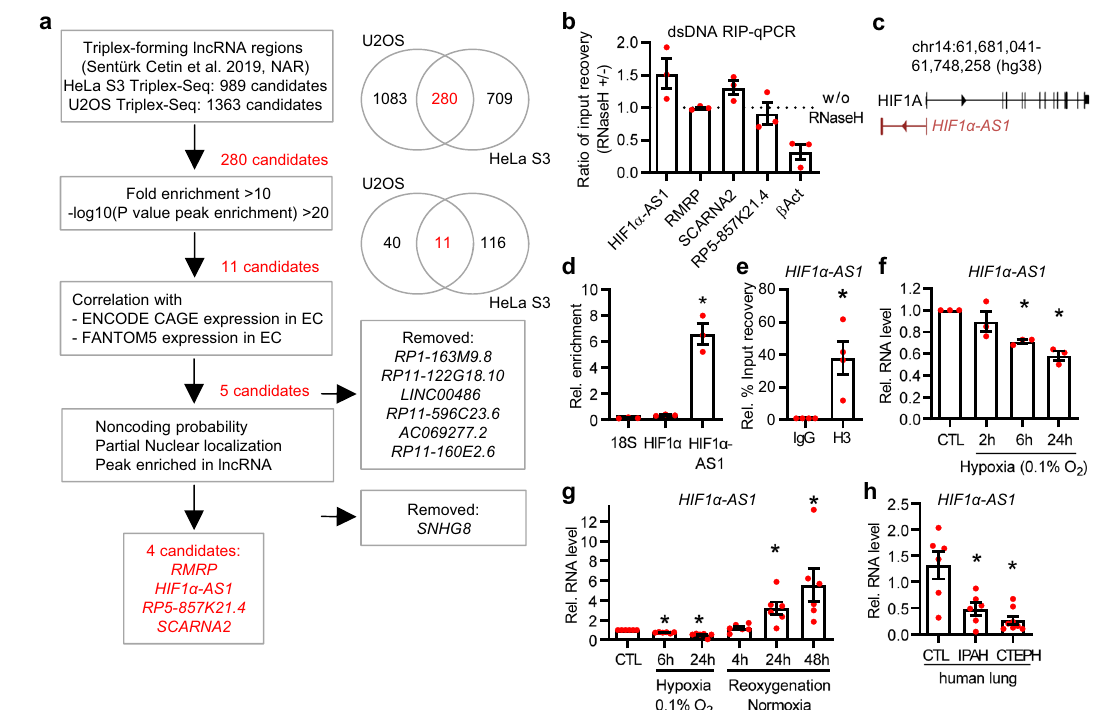
Fig.1| HIF1 α -AS1 isatriplex-andDNA-associatedRNaseH-insensitivelncRNAin endothelialcells.a Overviewoftheidenti fi cationofendothelial-expressedtriplex- forminglncRNAs.LncRNAsfromapreviousTriplex-SeqstudyinHeLaS3andU2OS wereoverlapped, fi lteredwithhighstringencyandanalyzed fornuclearexpression inendothelialcellswithENCODEandFANTOM5CAGEdatafollowedbyanalysesfor noncoding probability and enriched peaks in the Triplex-Seq data. b RNA- immunoprecipitation with anti-dsDNA antibody followed by qPCR (RIP-qPCR) tar- geting the lncRNA candidates in HUVEC. Samples were treated with or without RNaseH. β ActservedascontrolforRNaseH-mediateddegradation. n =3. c Scheme of the human genomic locus of HIF1 α -AS1 . d RT-qPCR after anti-dsDNA-RIP in HUVEC. HIF1 α and 18S rRNA served as negative control. One-way ANOVA with Tukey ’ stest, n =3.*( p =0.0002). e RIP-qPCRwithanti-histone3(H3)inHUVEC.Data was normalized against GAPDH. Paired t test, n =4. *( p =0.0364). f RT-qPCR of